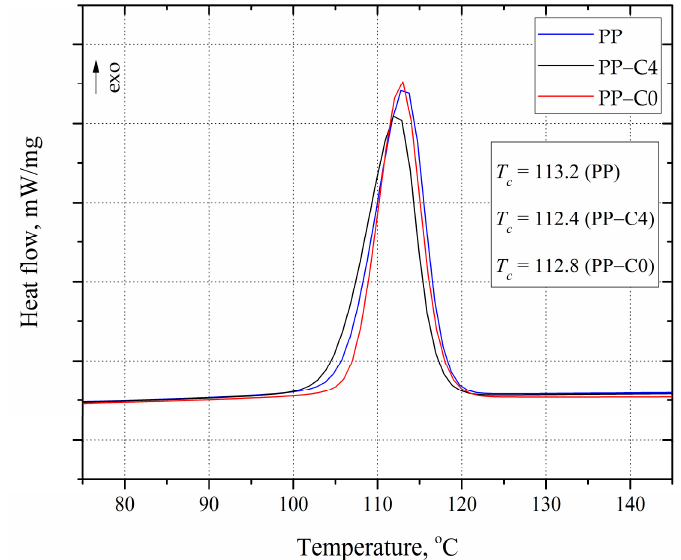
Figure 4. DSC crystallization curves of test samples.